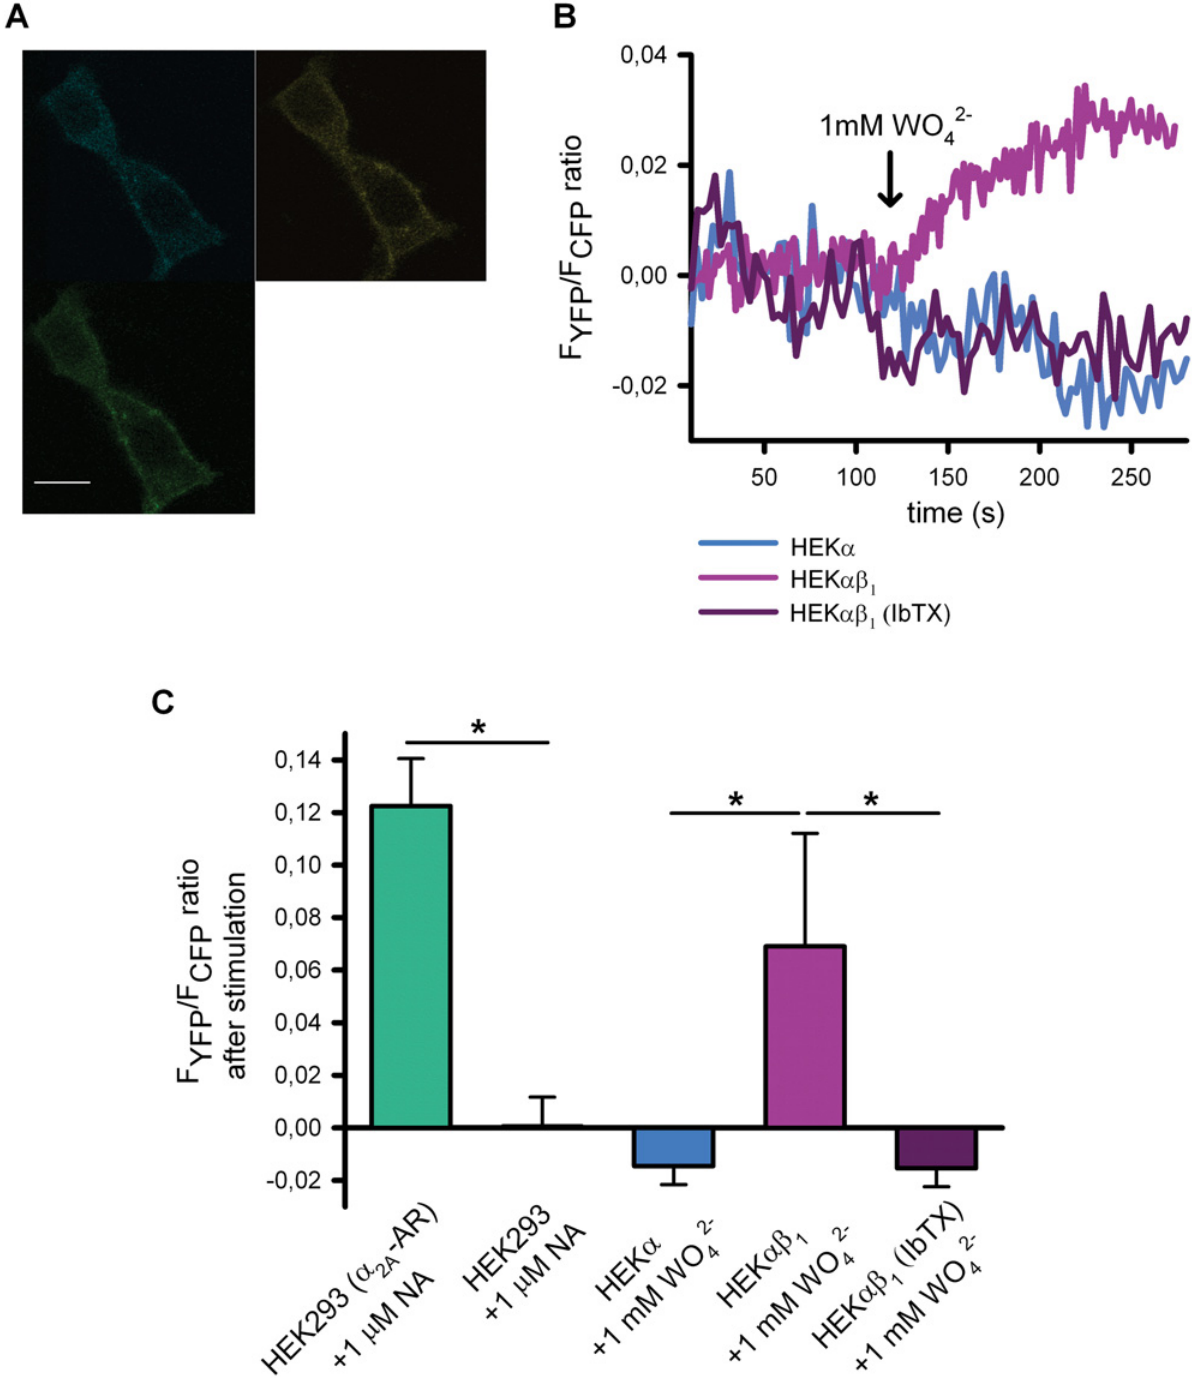
Fig 3. Tungstate-induced activation of heterologously expressed Gi/o proteins is mediated by BK αβ 1 channels. (A) Example of the reinforced membrane fluorescence pattern and emission levels from CFP channel (up-left), YFP (FRET channel) (up-right) and the merge channels (bottom-left) from HEK293 heterologously expressing G α i -YFP and CFP-G β . Fluorescence microscopy images were recorded by using confocal microscopy (for more details see Methods). FRET signal was determined by using donor ratiometric parameters (458/514) after excitation in the CFP frequency and registering in the YFP emission frequency. (B) Representative FRET changes from HEK293, HEK α or HEK αβ 1 cells transfected with the cDNAs of G protein subunits, in response to 1 mM tungstate (either in the absence or presence of IbTX), as indicated. (C), Average FRET changes for the different experimental conditions illustrated in B (n = 5 – 9). * P < 0.05 (Kruskal-Wallis test followed by Dunn post hoc